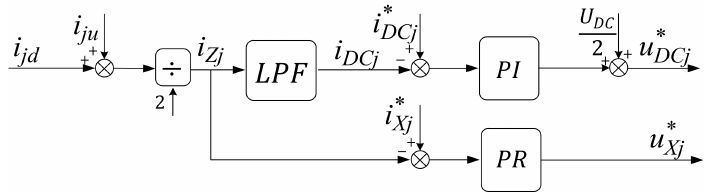
Figure 4. Block diagram for circulating current control.